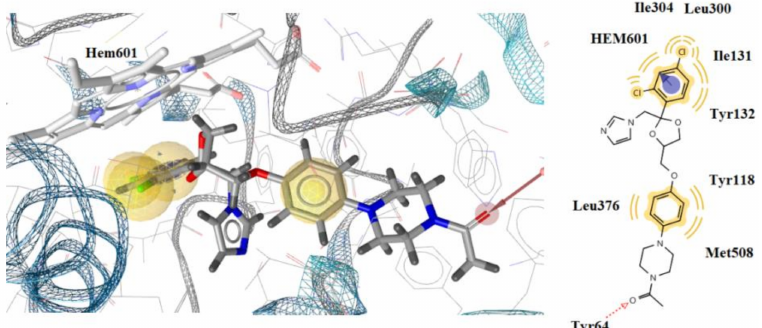
Figure 3. Docked conformation of reference drug ketoconazole in lanosterol 14 α -demethylase of C . albicans (CYP51 ca ). Red-dotted arrows indicate H-bond, blue spheres indicate the aromatic, and yellow spheres indicate the hydrophobic interactions.